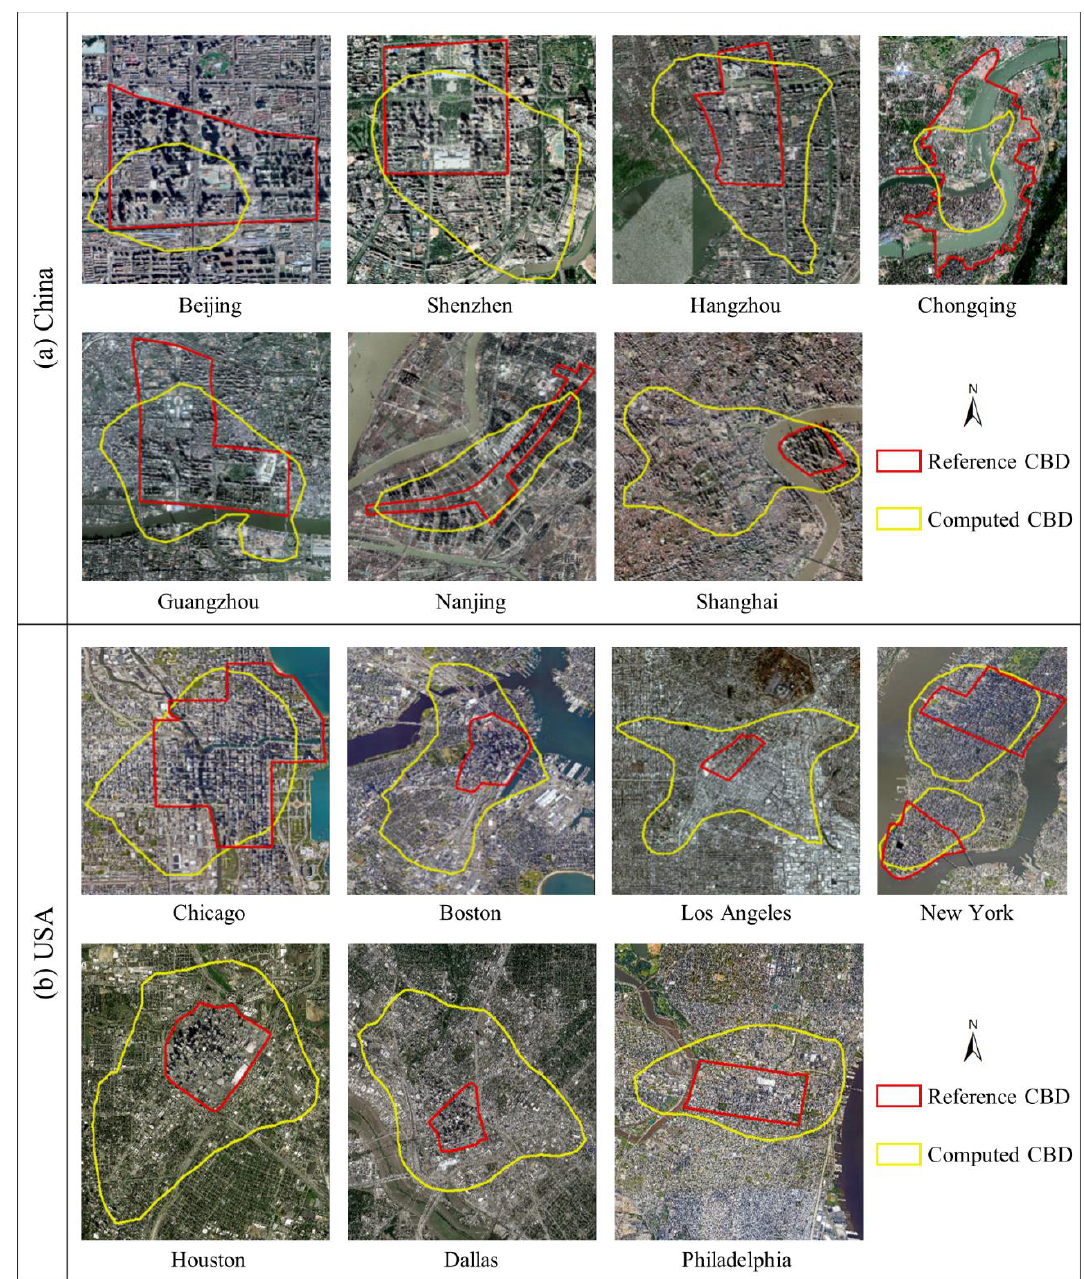
Figure 8. The reference and computed CBD boundaries and Google Earth image of the study cities. Table 6. Evaluation of urban CBD boundaries in China and the USA.